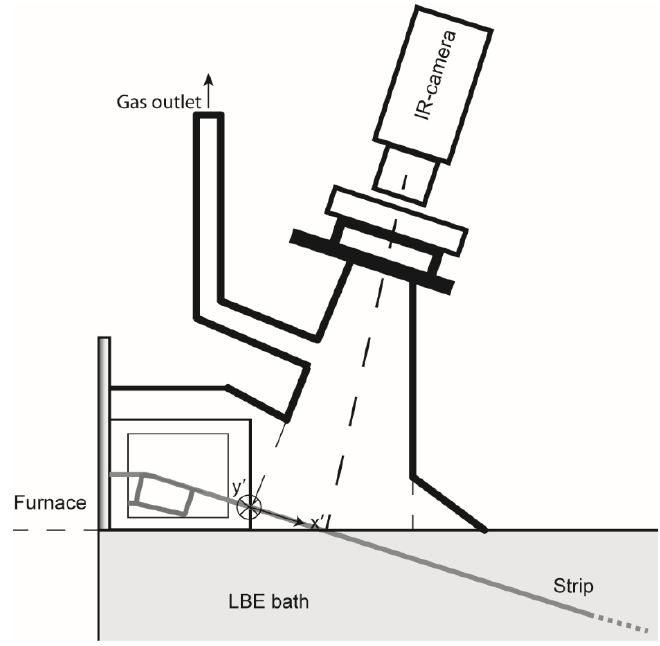
Figure 1. Schematic view of the setup for the temperature measurements at the hardening process. LBE: lead-bismuth eutectic.